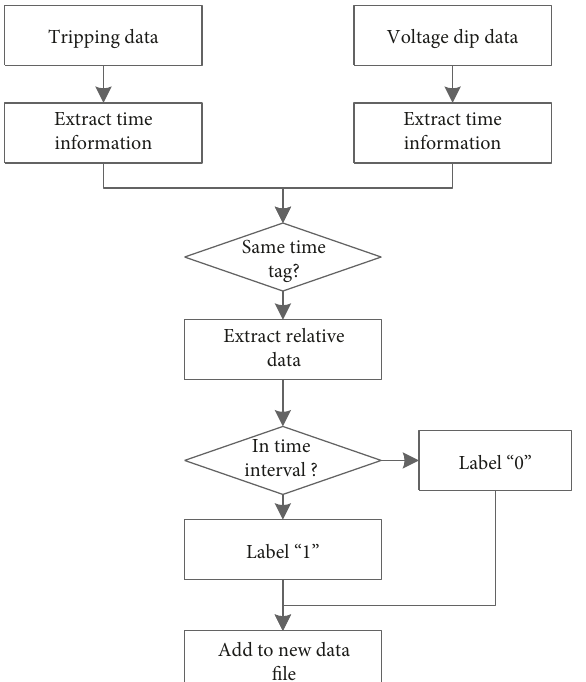
Figure 10: Diagram of data fi les fusion preprocess.